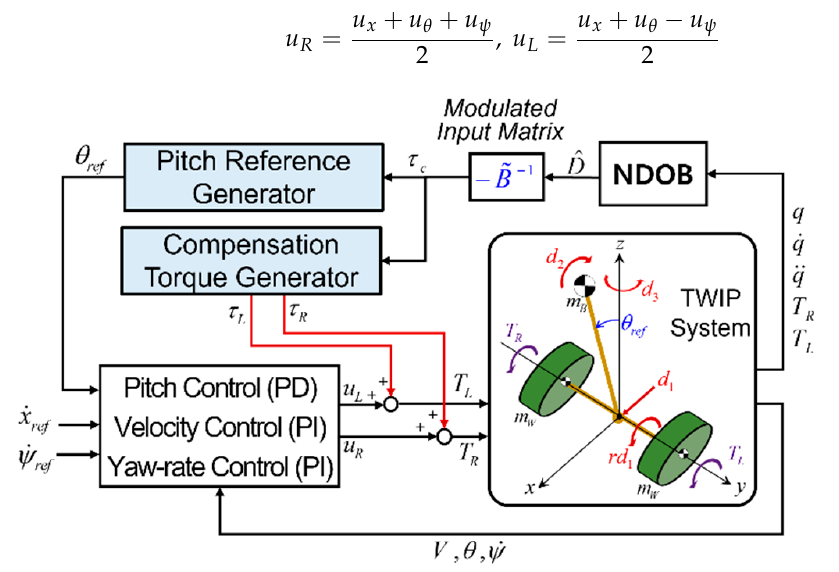
Figure 6. NDOB-based dynamic compensator with real-time pitch reference generation.